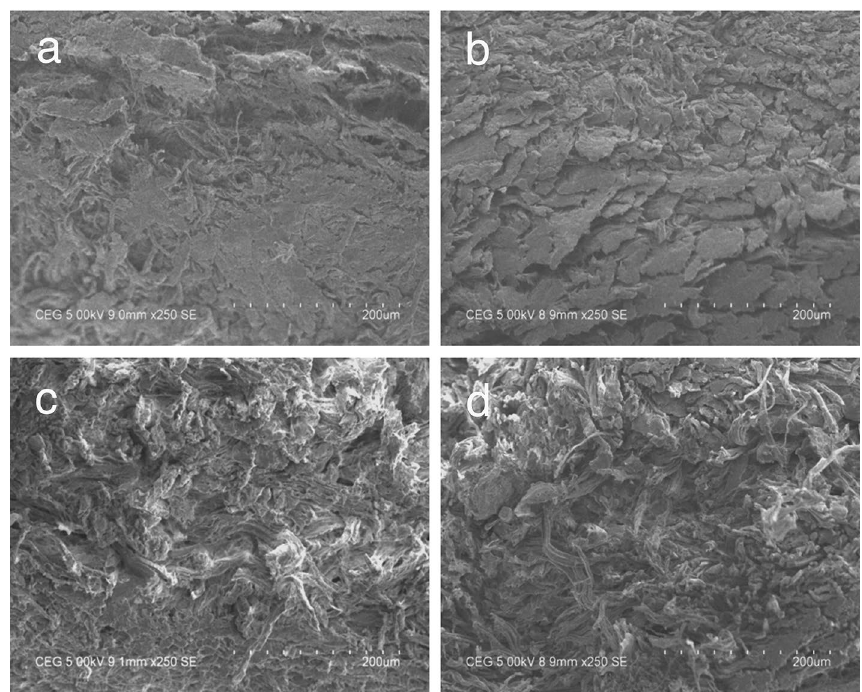
Figure 7. Scanning electron micrographs of cross section of control and experimental leathers at 250× magnification ( a ) Control (water), ( b ) Heptane, ( c ) Propylene glycol and ( d ) PEG